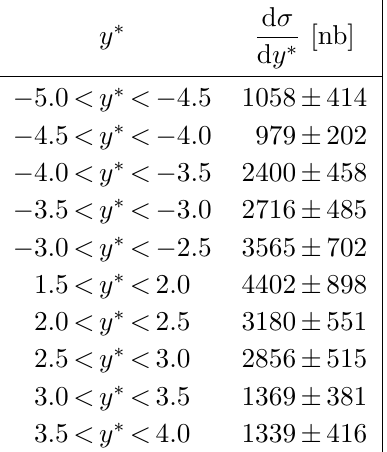
Table 9 . (cid:7) (2 S ) production cross-section in p Pb, as a function of y (cid:3)